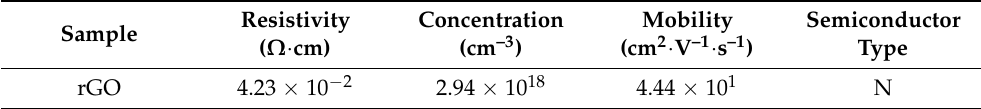
Table 2. Resistivity, concentration, mobility, and semiconductor type of rGO